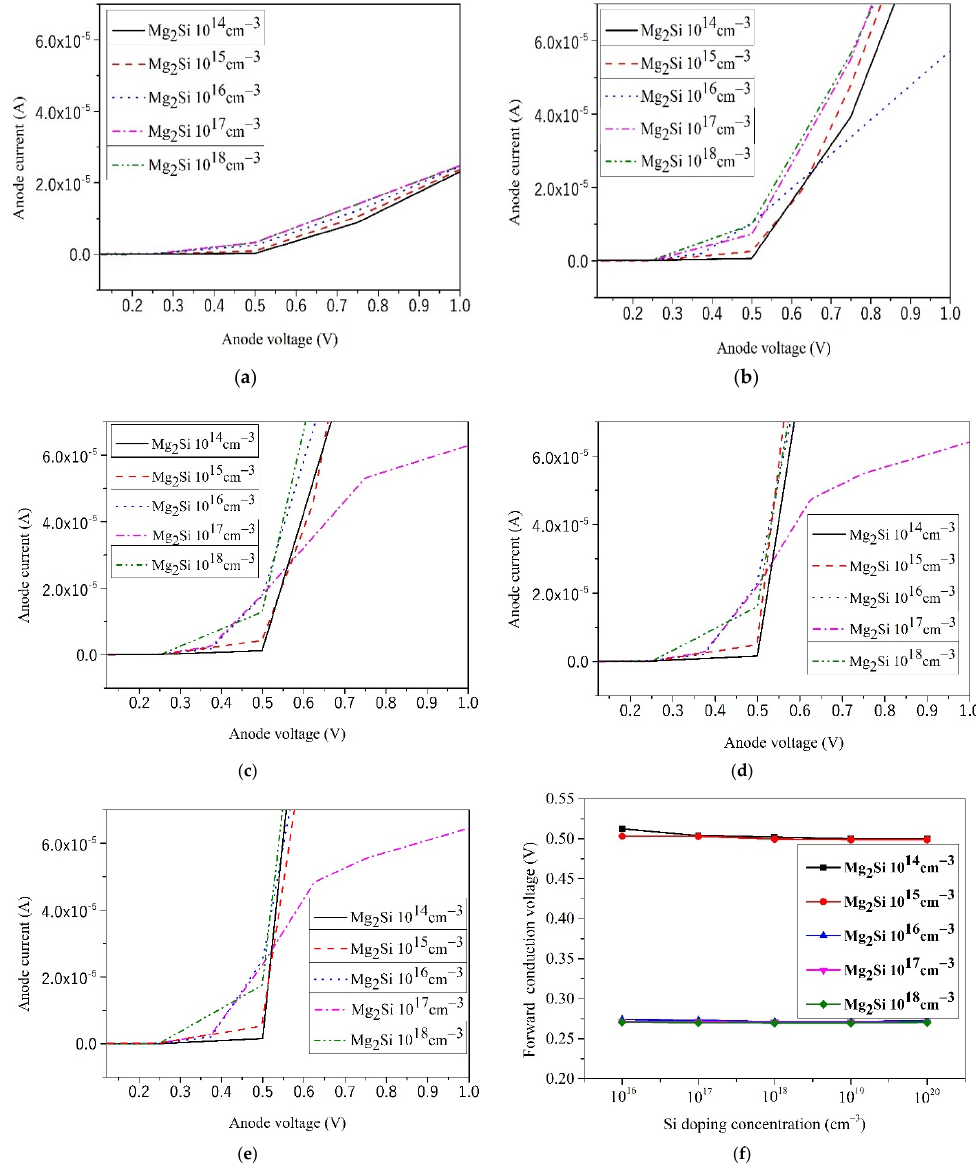
Figure 5. Forward I-V curves of the heterojunction PDs with different doping concentrations. ( a ) Si–10 16 cm − 3 . ( b ) Si–10 17 cm − 3 . ( c ) Si–10 18 cm − 3 . ( d ) Si–10 19 cm − 3 . ( e ) Si–10 20 cm − 3 . ( f ) The effect of doping concentrations on forward conduction voltage.